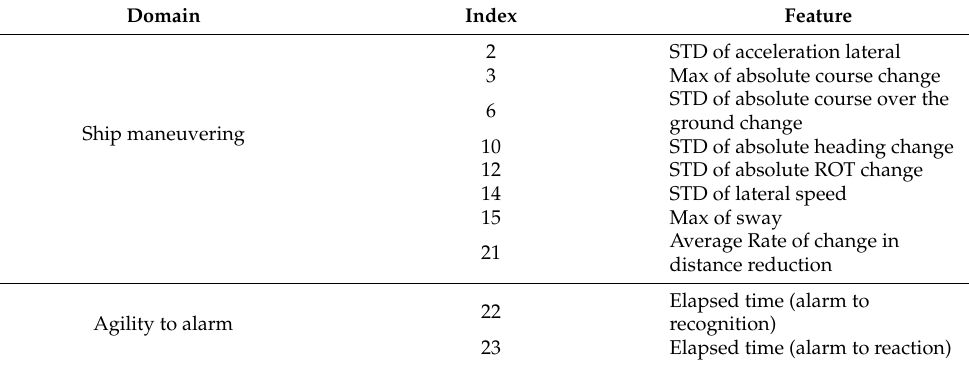
Figure 6. Correlation coefficient between features. Table 4. Selected features.